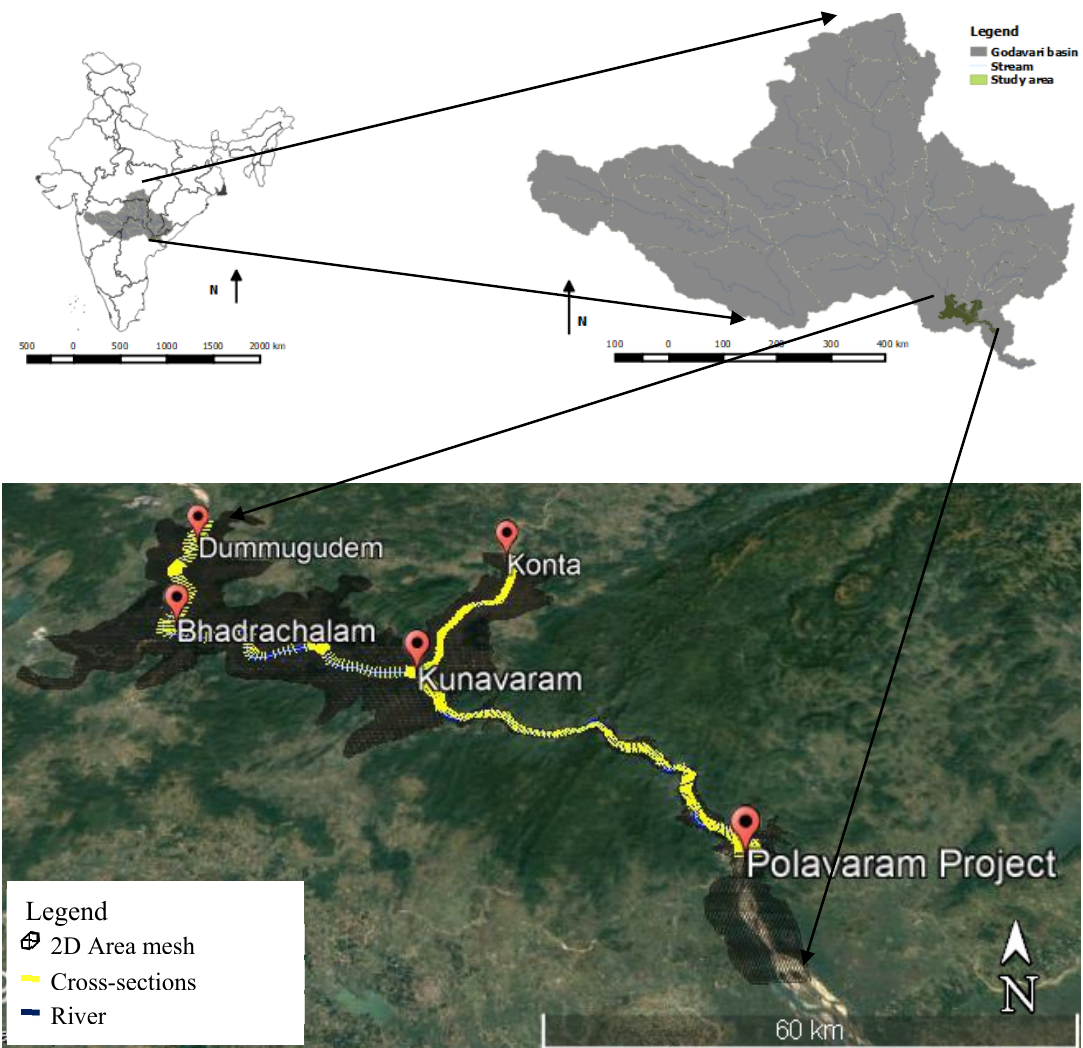
Figure 1. Study area location in Godavari basin from Dummugudem and konta in upstream of Godavari River till Polavaram project location with 2D flow area considered with cross-sections.